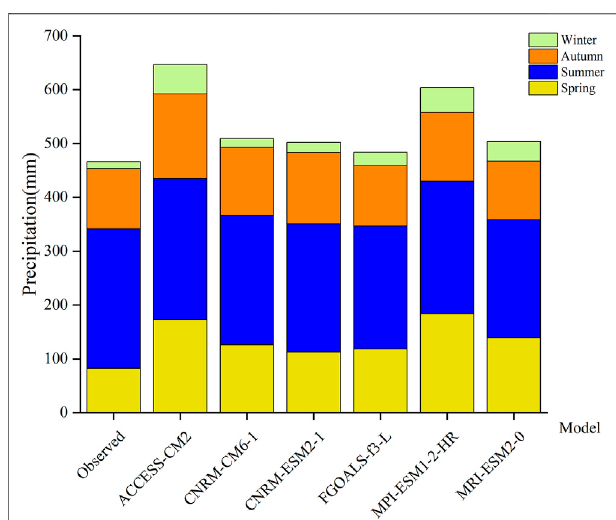
FIGURE6 | Distribution ofthe intra-year precipitation from thesimulated data of six higher-scoring GCMs and observed data.